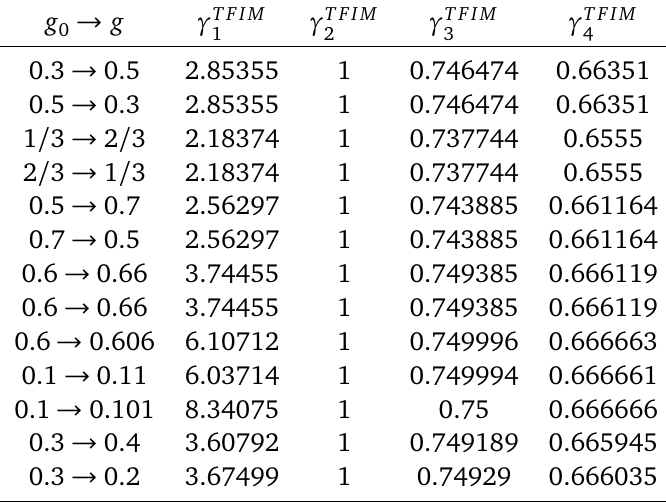
Table 2.1: Values of γ TFIM for a set of transverse quenches in the ferromagnetic phase n of the TFIM, in units obtained by setting J =